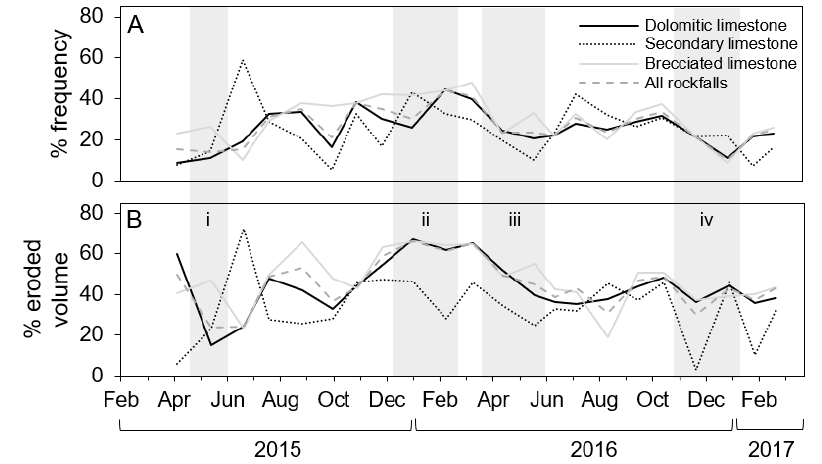
Figure 10. Progressive rockfall contributions in different lithologies, reflected as relative percentage of ( A ): Rockfall frequency, and ( B ): Eroded volume for successive differencing periods. Grey shading and i–iv annotation highlight periods that include notable storm events and can be cross-referenced to Figure 11. Data were de-trended to remove the effect of decreasing ‘fresh’ surface area through time, an effect that produced a residual positive linear trend in both relative progressive rockfall (PRF) frequency and eroded volume through time, upon which monthly variations were superimposed.